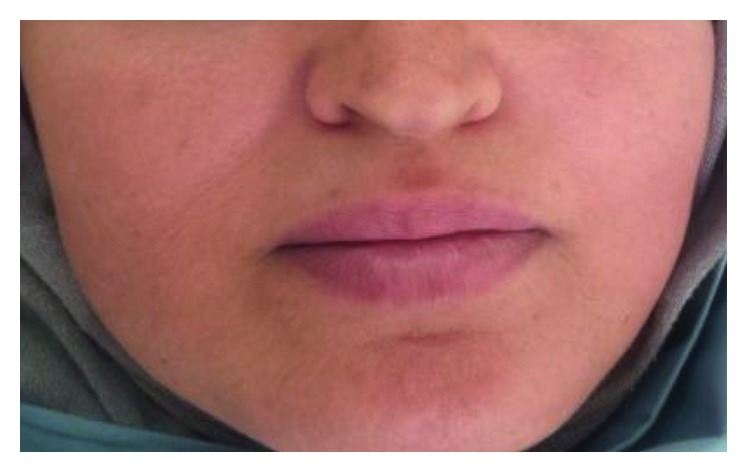
Clinical picture: slight asymmetry with swelling on the right side of the face.